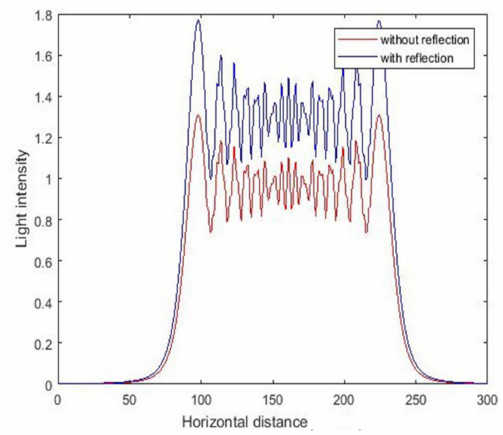
Figure 9. The intensity curve for vertical exposure at depth of 150 µ m.